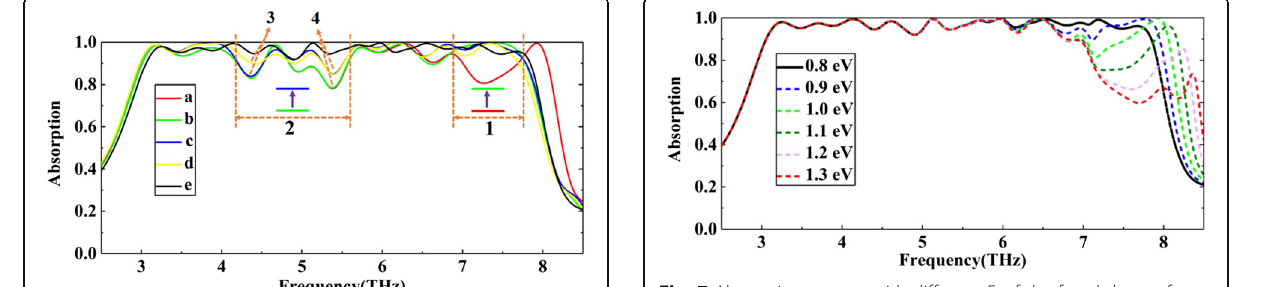
Fig. 7 Absorption spectra with different E f of the fourth layer of graphene and with unchanged E f of other layers of